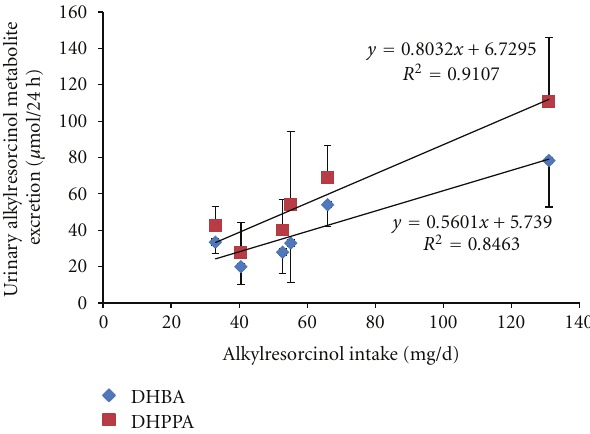
Figure 5: Relationship between mean AR intake and the mean of urinary AR from three published studies. Where direct AR intake data was not provided, it was estimated from literature values if possible. Values are arithmetic means, and error bars are the standard